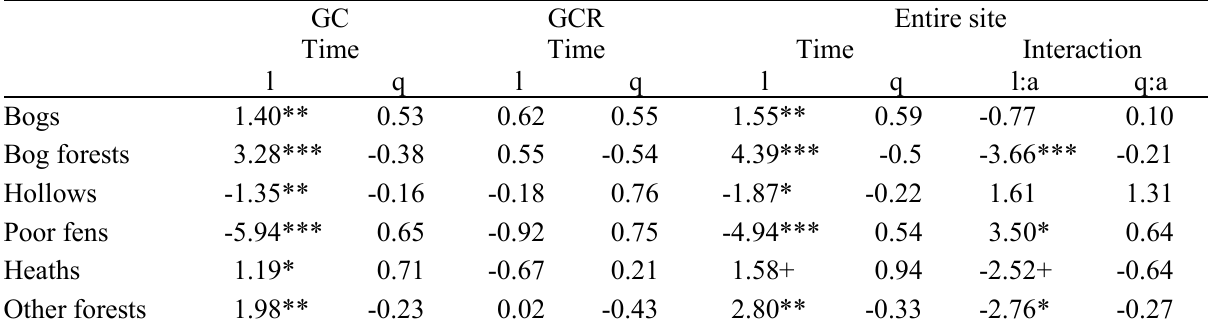
Table 4. Trends of the relative species number (np) of species belonging to various habitats in the two areas (GC and GCR) and the entire site. Results of separate regression models for the GC-area and GCR-area, as well as results from the combined model, are shown. Numbers are the effect sizes of the orthogonal polynomials of time and their interaction with area type. GC = grazing cessation; GCR= grazing cessation and rewetting; l:a = interaction linear term between time and area type; q:a = interaction quadratic term between time and area type. Significance levels: +: p ≤ 0.1; *: p ≤ 0.05; **: p ≤ 0.01; ***: p ≤